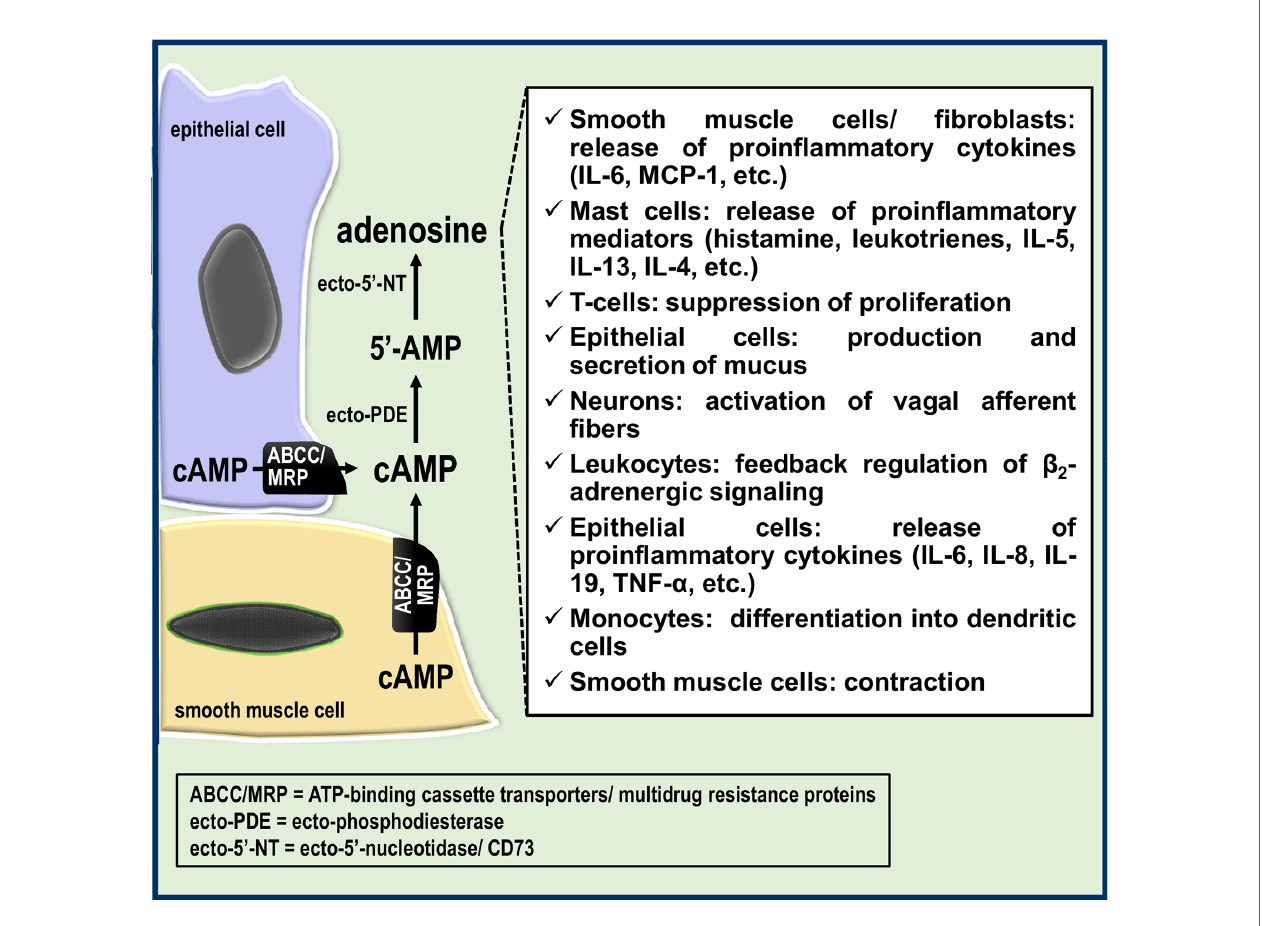
FIGURE 2 | Potential roles of the extracellular cAMP-adenosine pathway in the airways. Part of the cAMP formed in epithelial and smooth muscle cells is transported by ABCC/MRP transporters to the extracellular milieu, giving rise to extracellular adenosine, which in turn can modulate the airway immune response and bronchial